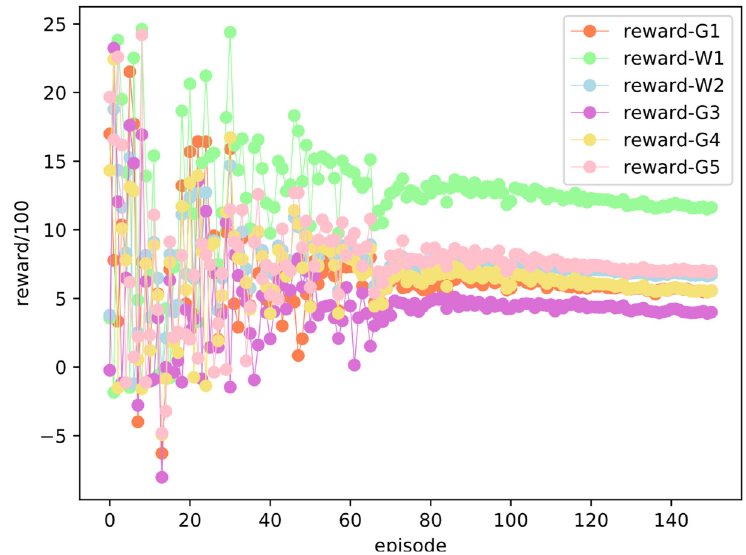
Figure 11. DDPG training revenue results of each generator.